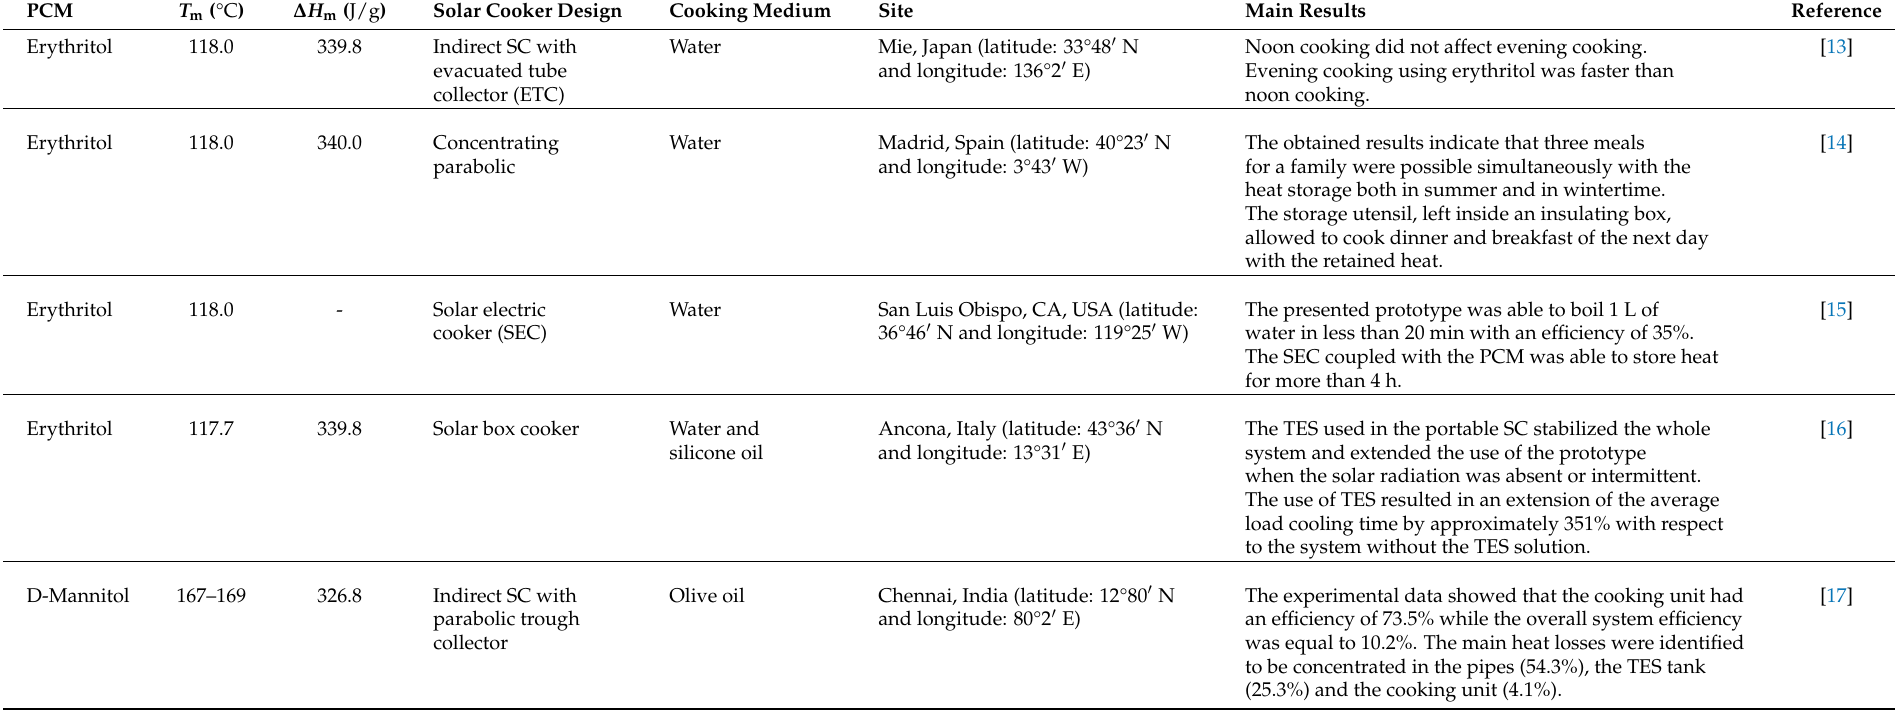
Table 1. Literature summary of sugar alcohols used experimentally as phase change materials (PCMs) in direct and indirect solar cookers